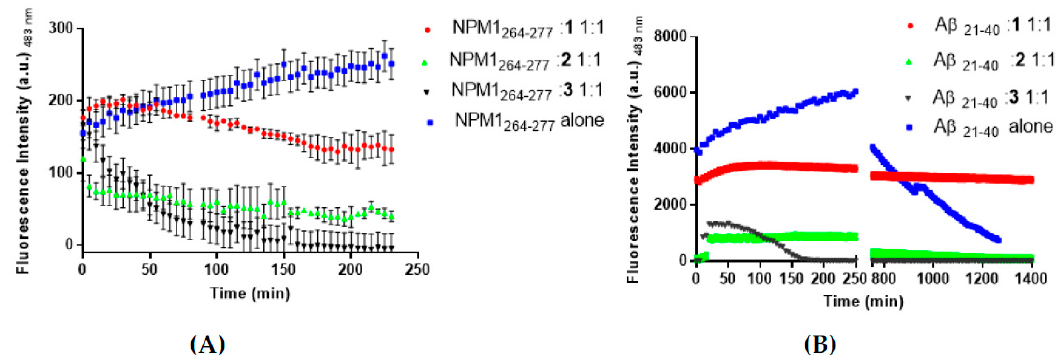
Figure 2. Time-course of ThT fluorescence emission intensity of NPM1 264–277 (panel A ) and A β 21–40 (panel B ) in the presence of 1 – 3, upon incubation at 1:1 peptide to metal compound molar ratio. The peptides alone are reported as blue squares. Results are representative of two independent experiments.